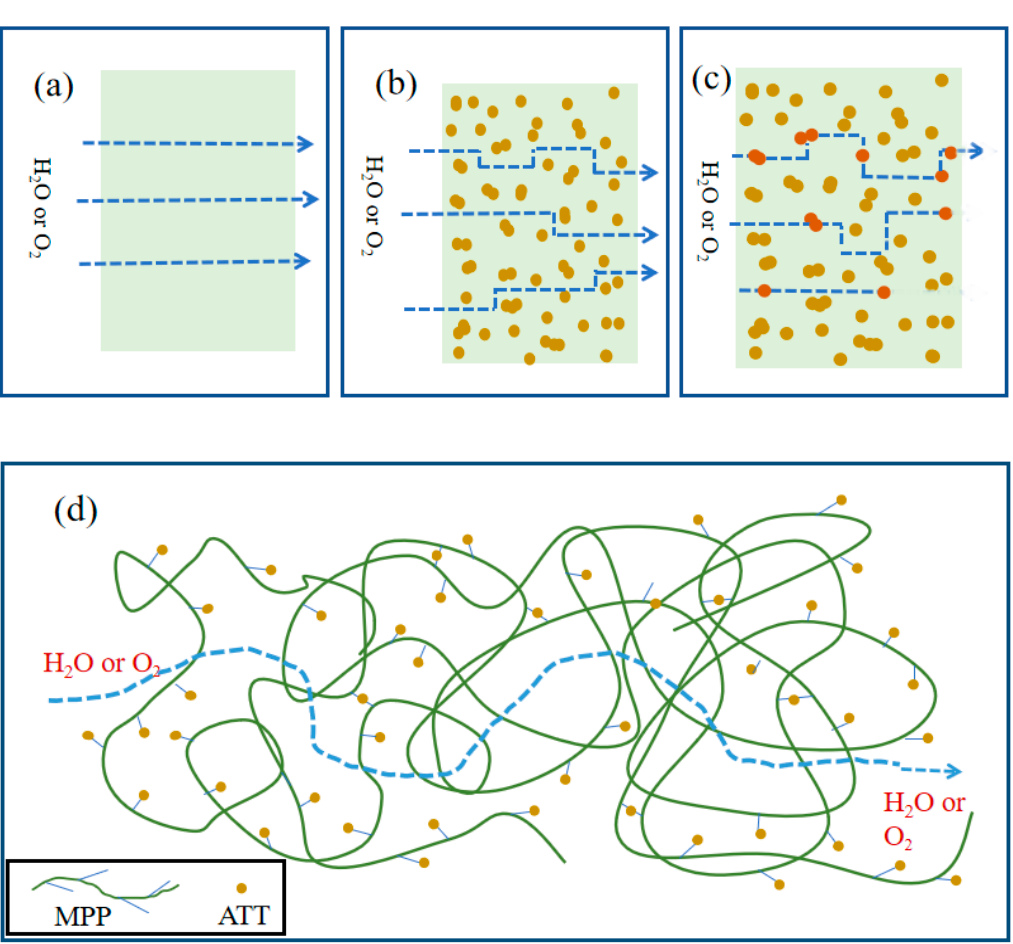
Figure 11. Schematic diagram of gas molecules diffusing through MPP or MPP/ATT nanocomposite: ( a ) diffusion path through MPP; ( b ) diffusion path around MPP/ATT nanocomposite; ( c ) diffusion path within and about MPP/ATT nanocomposite; ( d ) diffusion of water and gas molecules through nanocomposite.